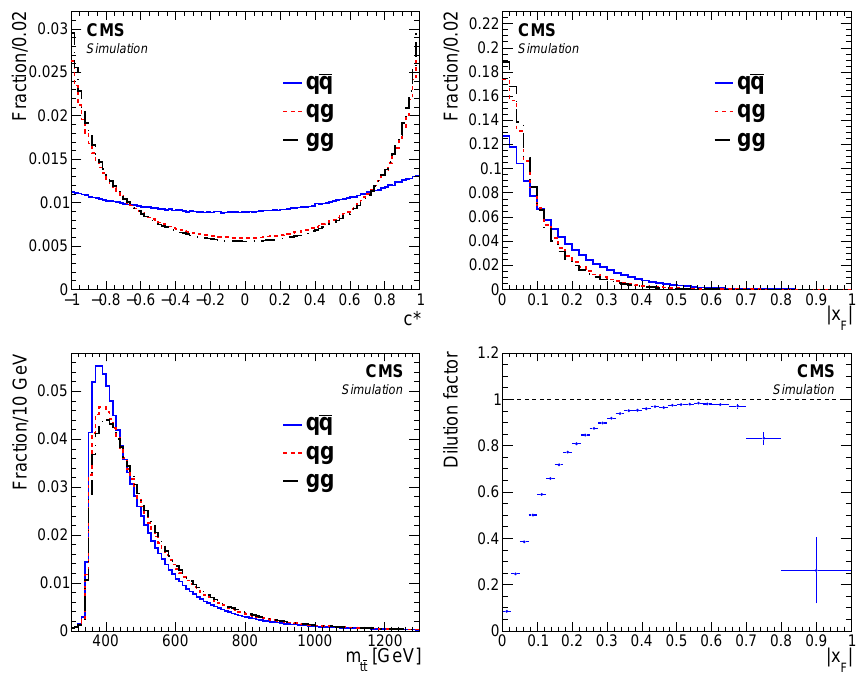
Figure 26. Normalized distributions at generator level of c ∗ ( upper left ), | x F | ( upper right ), and m t ¯ t ( lower left ) for three different t ¯ t production modes. The dillution factor for the assumption that the quark direction in qg events is given by the longitudinal direction of the t ¯ t pair as a function of | ( x F | ( upper right )